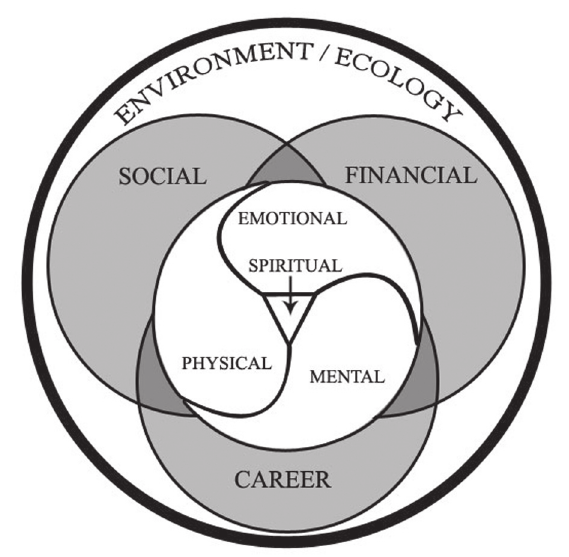
figure 1: Smith’s pIpl life Dimensions